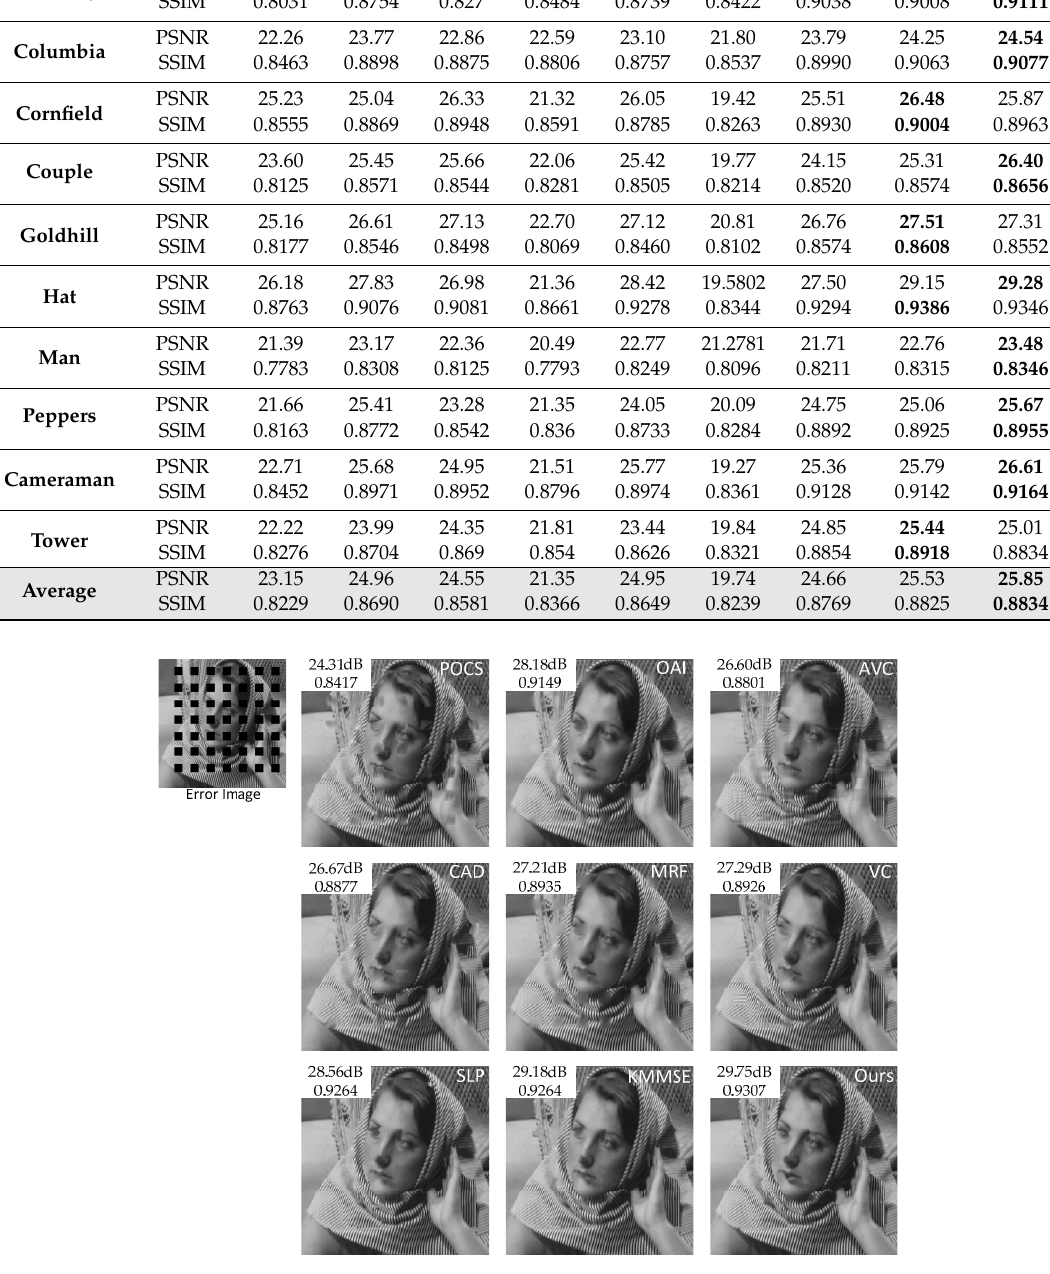
Figure 19. Subjective comparison of different EC algorithms on the Barbara image with 16 × 16 isolate block loss. The corresponding PSNR and SSIM values are also shown in the upper left corner.